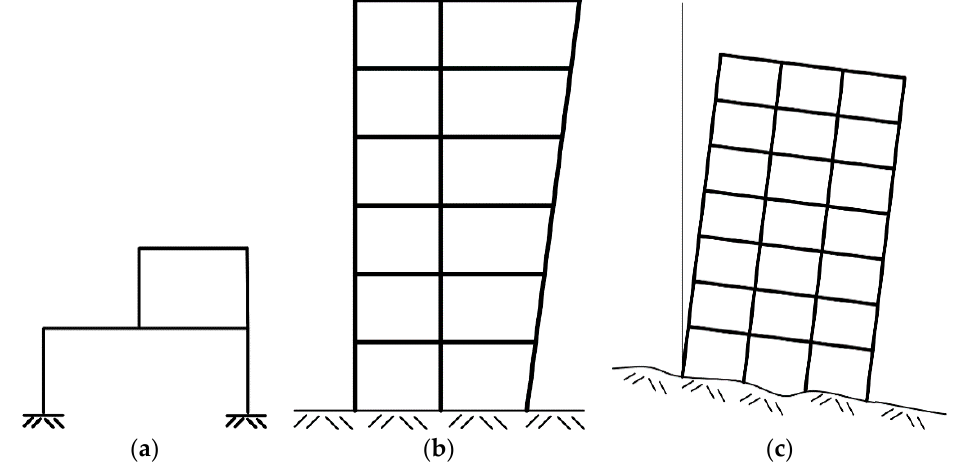
Figure 1. Some examples of structures with asymmetric yielding: ( a ) asymmetry in vertical loads; ( b ) structures with sloping facades; ( c ) tilting.